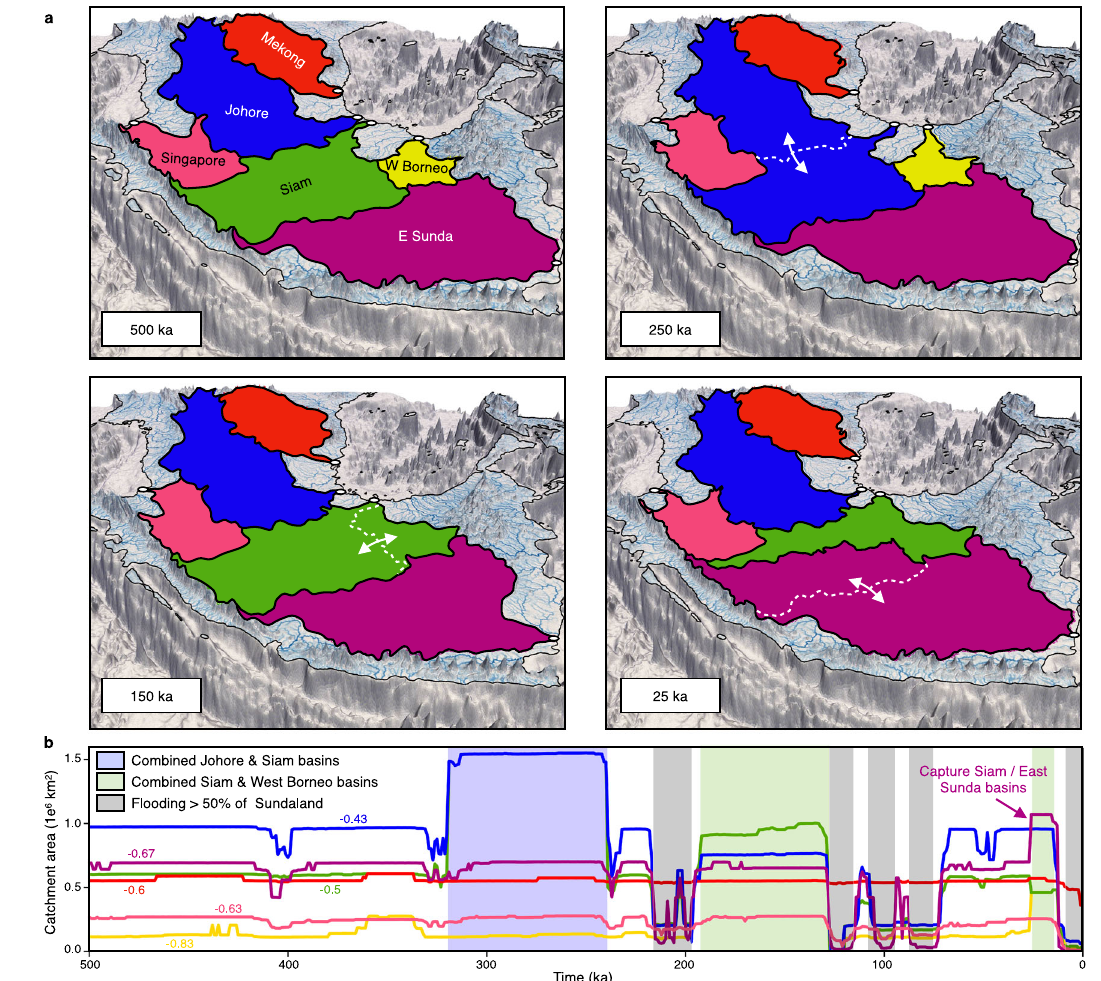
Fig. 3 Temporal evolution of Sundaland drainage basins distribution and changes in main catchments characteristic. a Evolution of drainage basins tessellating the Sunda Shelf for scenario 5. Basins are generated from the simulation results based on fl ow accumulation and direction. The drainage divide positions are changing over time but these changes, expect during reorganisations and captures, are limited due to small tectonic rates and shelf physiography. b Catchment areas over the last 500 kyr for the Johore, Siam, Mekong, East Sunda, Singapore and West Borneo basins (coloured lines refer to coloured basins in ( a )). Pearson ’ s coef fi cients of correlation between area and sea level fl uctuations 37 are also